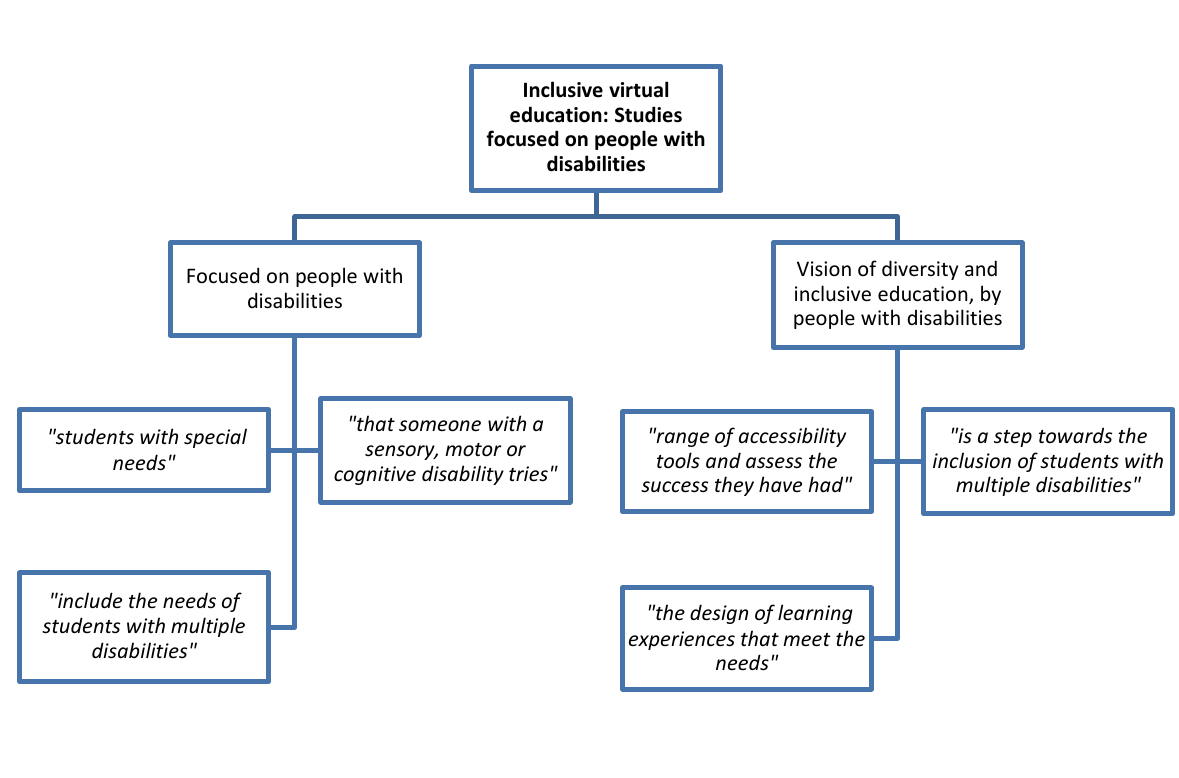
Figure 2 . Studies focused on people with disabilities. This mind map illustrates the subcategory and its properties. Regarding the properties, some of the text is framed in quotation marks and italics, which correspond to brief textual quotations of some of the articles